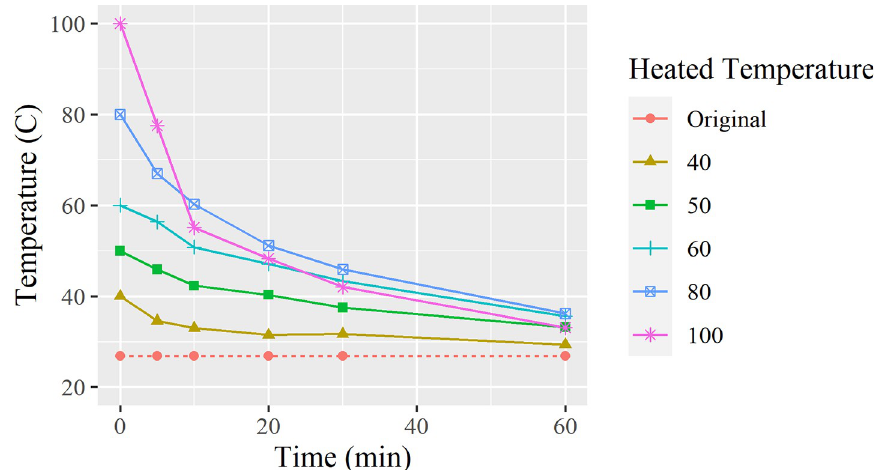
Fig 1. Temperature change overtime for each starting temperature.